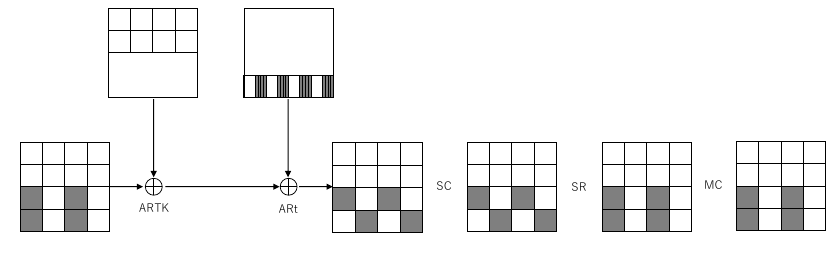
Figure 14: One-Round Iterative Differential in Row-wise Addition. ARC is